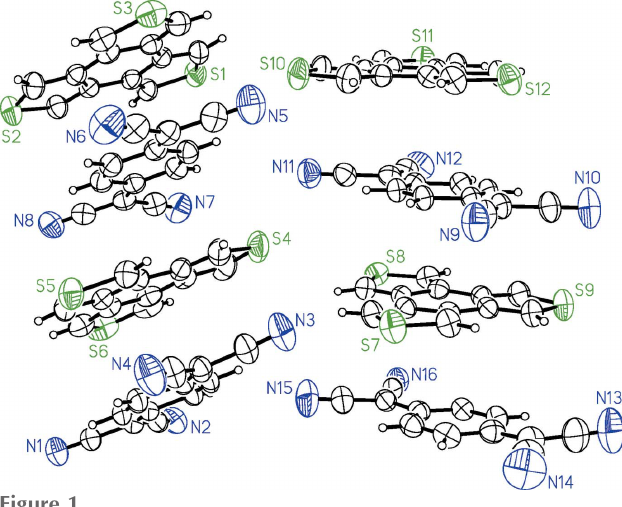
Figure 1 The asymmetric unit of D 3h -BTT (cid:2) TCNQ. Carbon atom labels have been omitted for clarity.